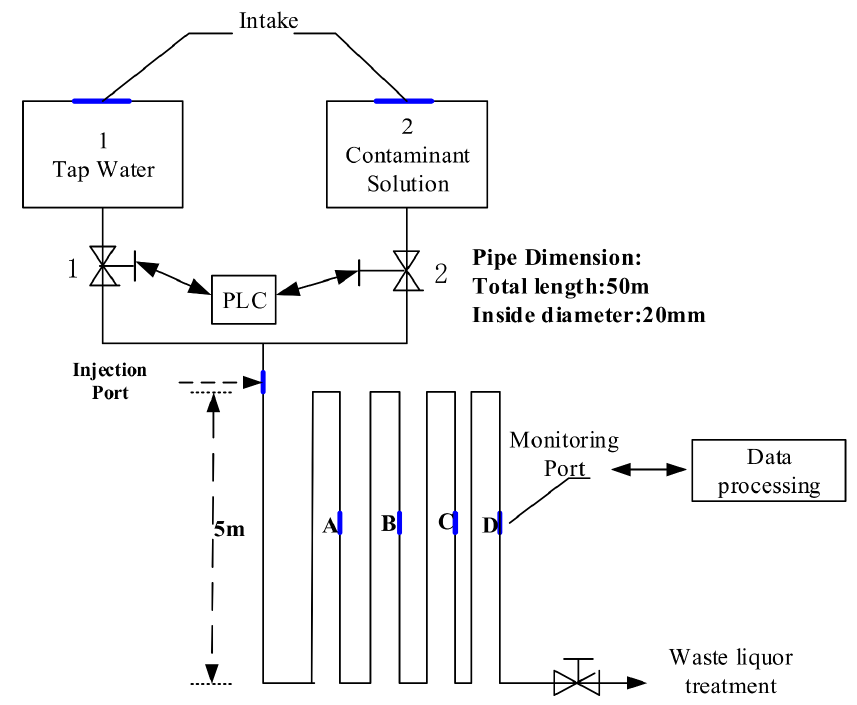
Figure 2. Experimental setup of a small-scale distribution pipe device. PLC: programmable logic controller. Water quality can be monitored at points A, B, C, and D.